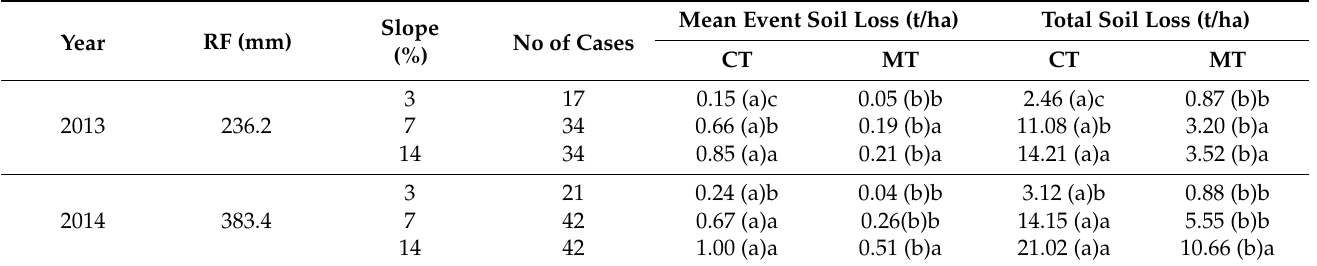
Table 2. Soil loss from conventional tillage (CT) and conservation tillage (MT)